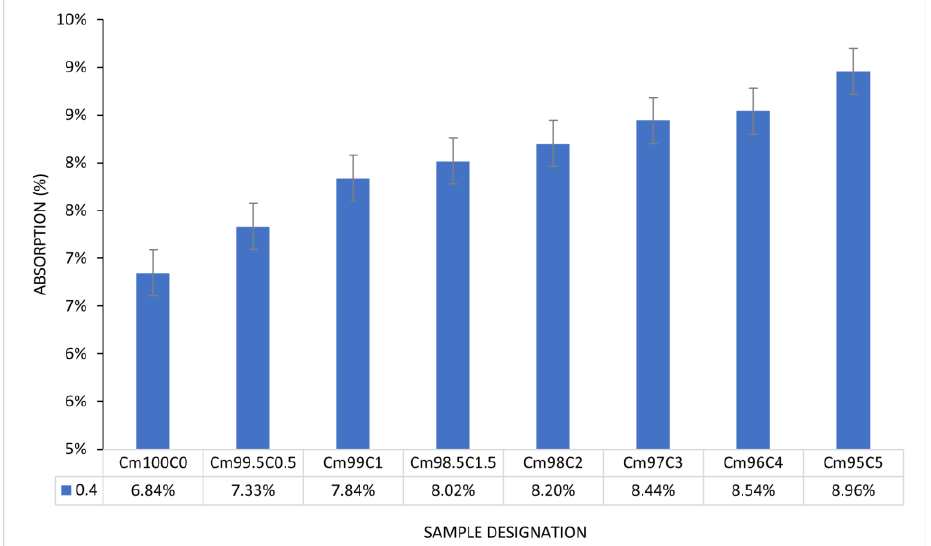
Figure 11. Water absorption of coffee-silverskin-blended mortar.